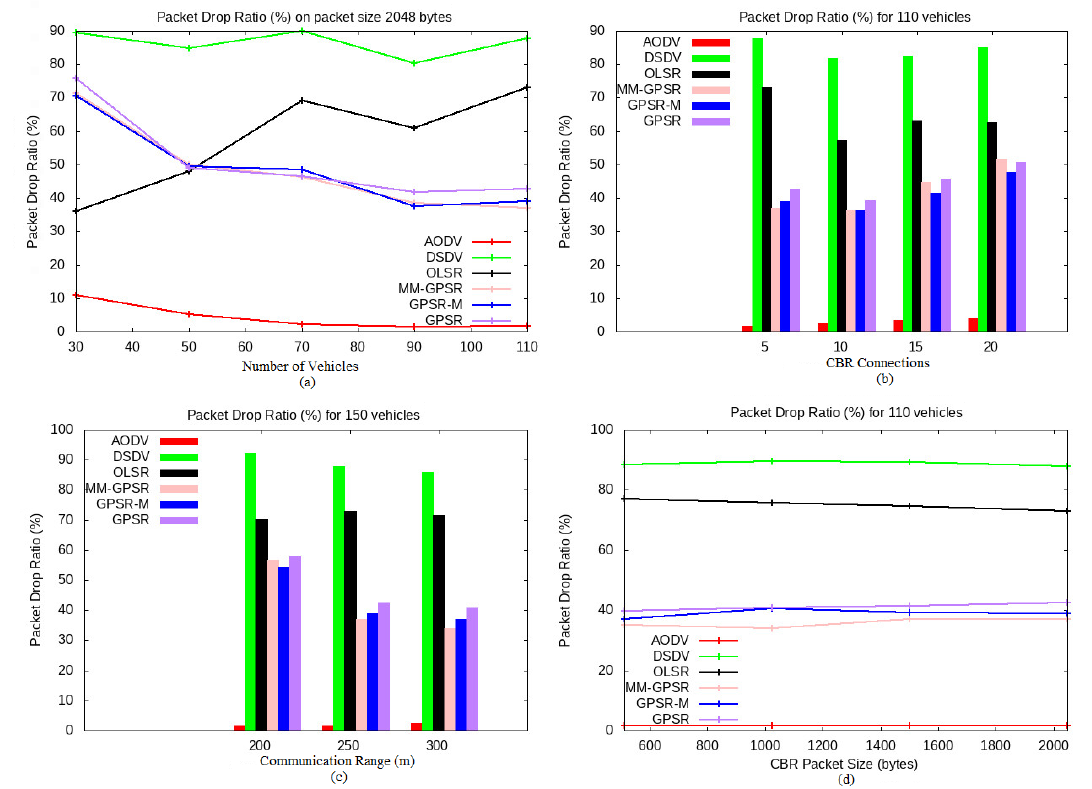
Figure 5. PLR results on various network